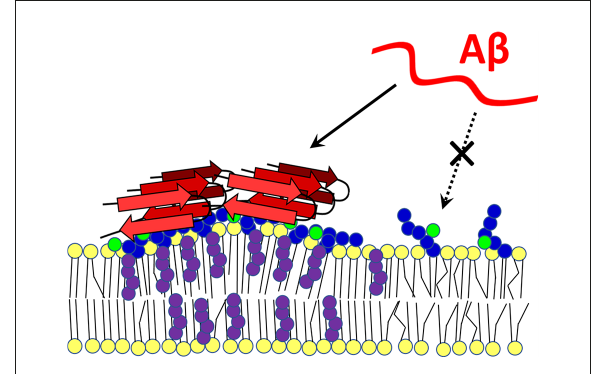
FIGURE3 Cholesterol-dependent GM1 clustering and A β -membrane binding. Ganglioside GM1 was found to form membrane clusters in a cholesterol-dependent manner. Aggregated GM1 exists in a different spatial configuration that favors A β binding. With its -OH group, cholesterol forms a hydrogen bond with a sugar moiety of the polar group of the ganglioside, which positions it parallel to the membrane. When not bound to cholesterol, the polar head of the lipid is less able to interact with the amyloid peptide (dashed arrow). Red—amyloid β , yellow—membrane lipids, purple—cholesterol, blue—sugars in GM1 polar head, green—sialic acid. The scheme was prepared according to Yahi et al. (2010) and Matsuzaki